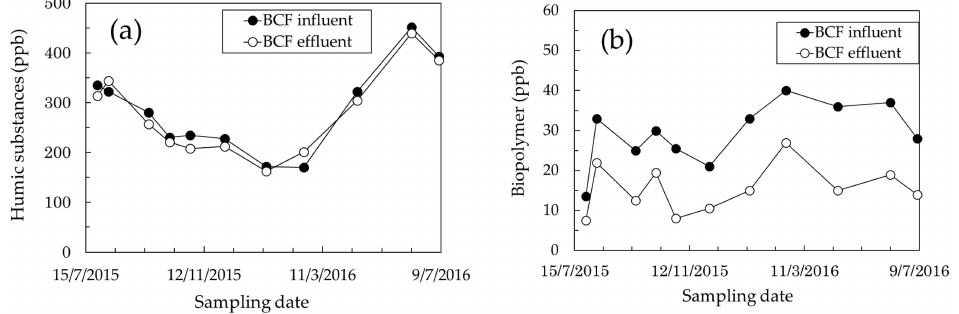
Figure 7. Seasonal change of ( a ) humic substances and ( b ) biopolymer in the influent (closed circles) and effluent (open circles) of BCF.